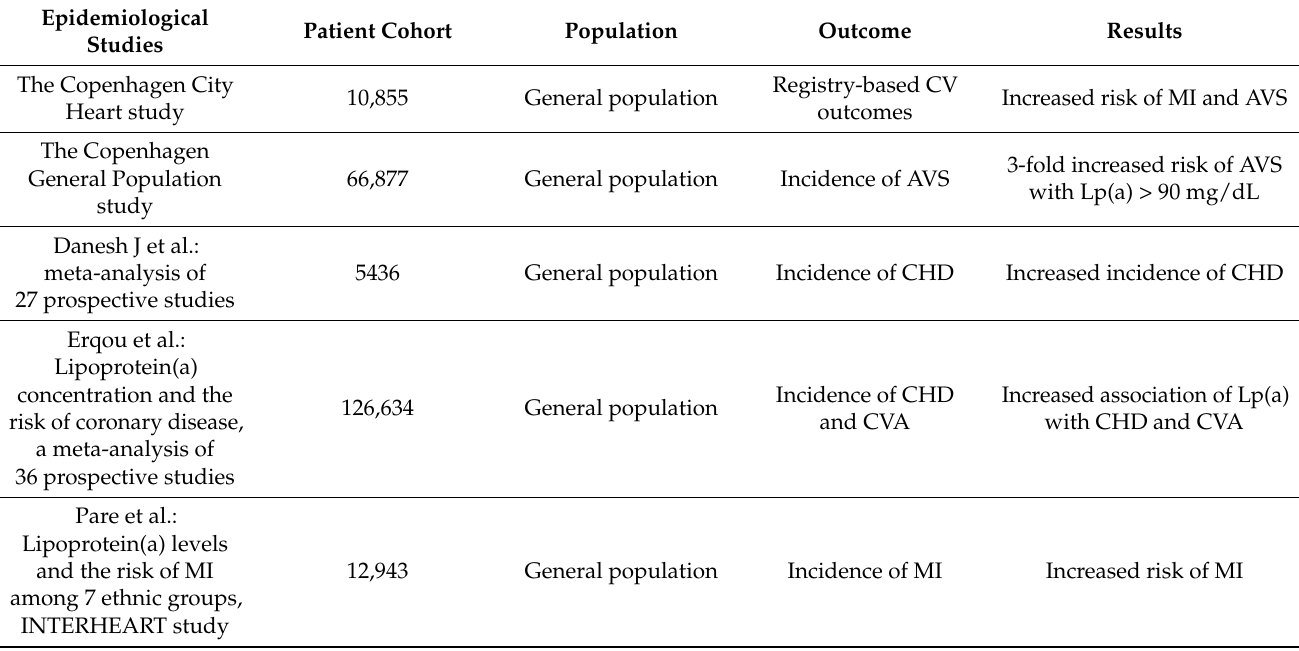
Table 1. Epidemiological studies suggesting a causal role of Lp(a) in